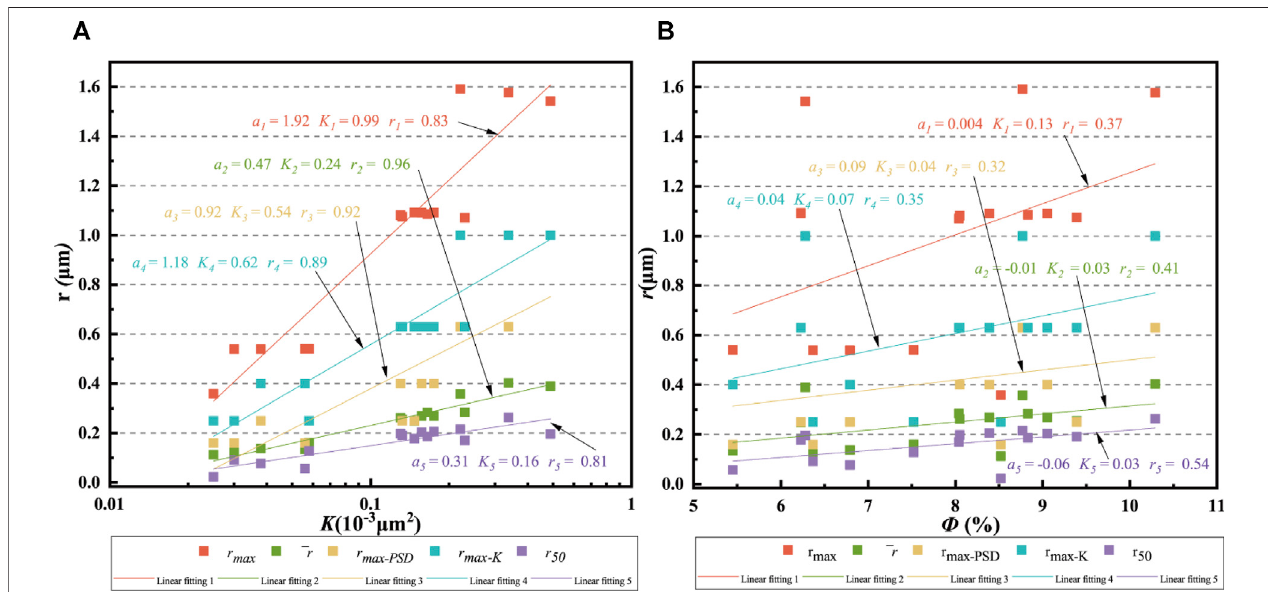
FIGURE 11 | Correlation relationships between permeability (A) , porosity (B), and fi ve representative pore/throat-size-related parameters.